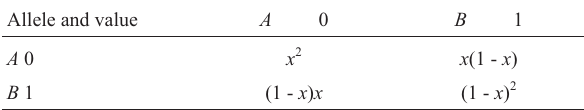
Table 2 - Probabilities of independently-drawn gene pairs in a